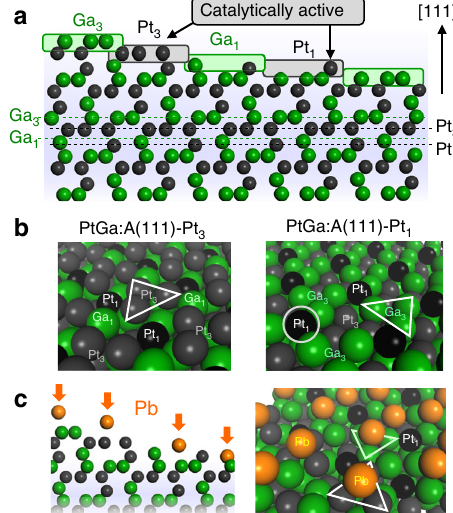
Fig. 1 Catalyst design of single-atom Pt in PtGa. a Four different surface terminations of PtGa:A(111) viewed along [101] direction (ball model). b Diagonal view of Pt 3 and Pt 1 termination (space- fi lling model). Pt 1 is highlighted with black color. c Catalyst design by Pb deposition to block the Pt 3 (and Ga 3 ) sites and to keep the Pt 1 sites available.